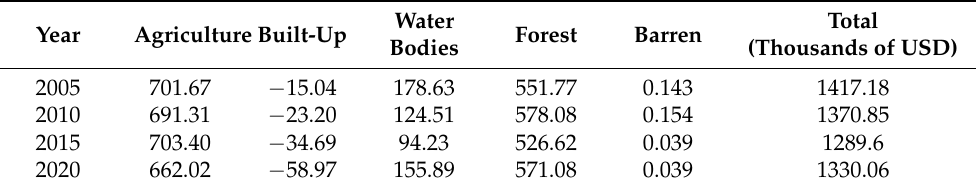
Table 6. The economic value of ecosystem services (in thousands of USD) for Rupandehi District,